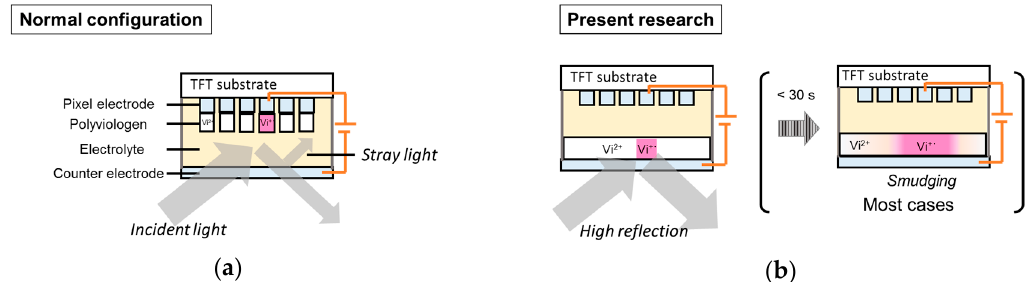
Figure 1. Schematics for electrochromic displays installed with thin film transistor (TFT) substrates and smudging phenomenon. Vi 2+ and Vi + stands for dication and cation states of viologen units, respectively.